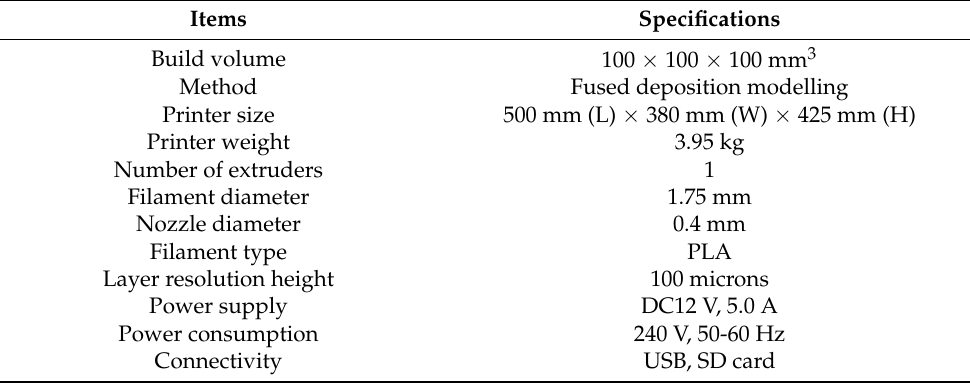
Figure 5. Designed objects printed using the fabricated 3D printing machine: ( a ) calibration cube; ( b ) bevel gear, spur gear, outer human ear, and foot; ( c ) nose mask; ( d ) fixture holding the electric motor controlling the z-axis. Table 2. Specification of the constructed 3D printer.